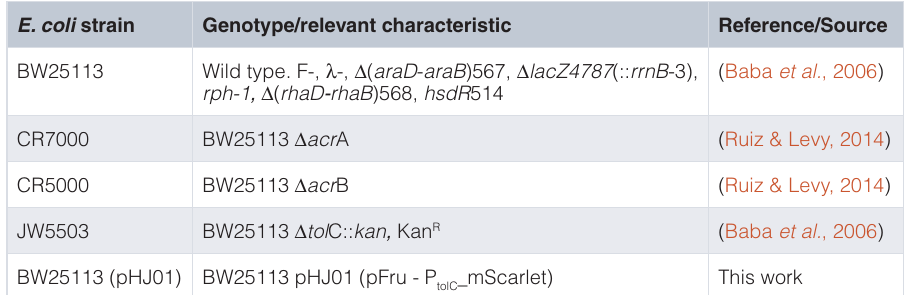
Table 1. E. coli strains used in this